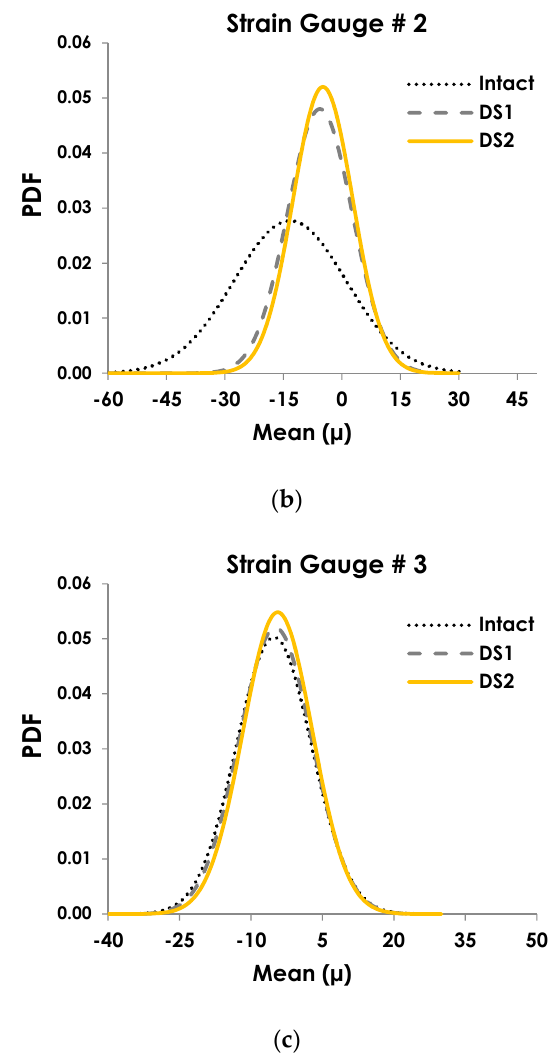
Figure 7. The relationship between the probability density function (PDF) patterns and damage progression. (a) strain gauge # 1 (b) strain gauge # 2, and (c) strain gauge # 3.